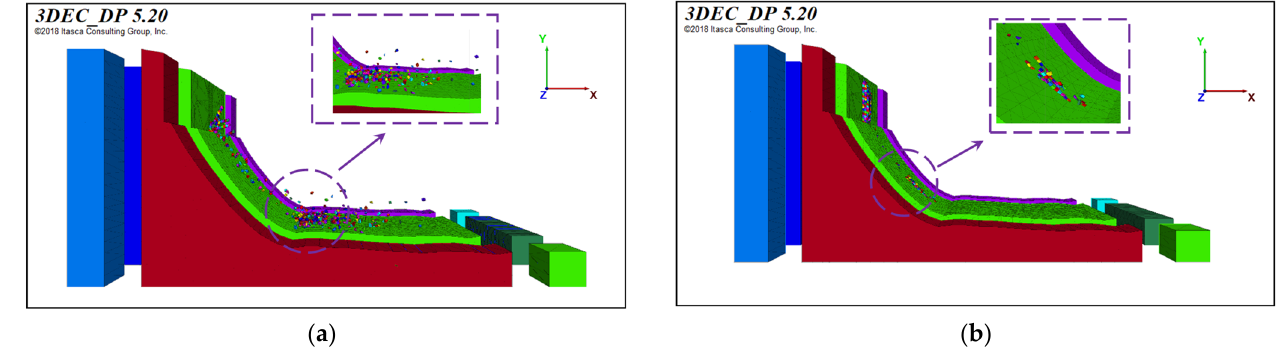
Figure 20. Numerical results of local damping 0.001 ( a ) and 0.01 ( b ) under three ‐ directional seismic wave.